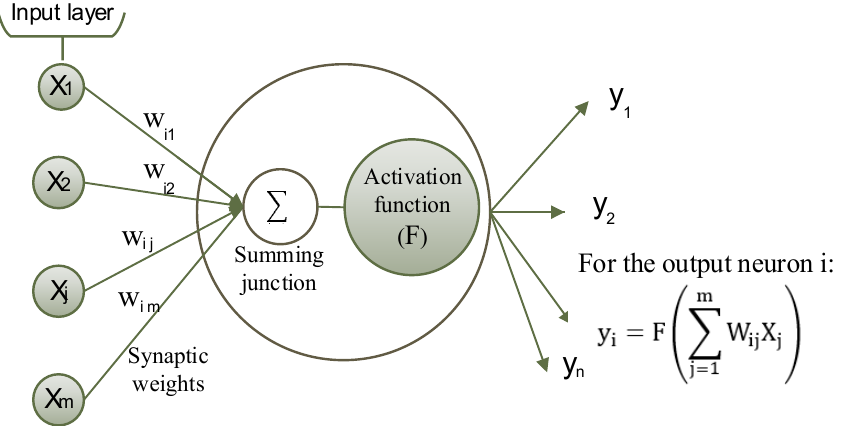
Figure 17. The structure of typical artificial neuron processing in a neural network (NN) unit. Implementation of traditional ANN forecast models: